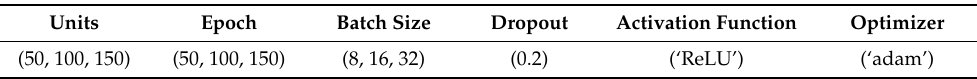
Table 2. Hyperparameter range for the selection of the best GRU and LSTM models.